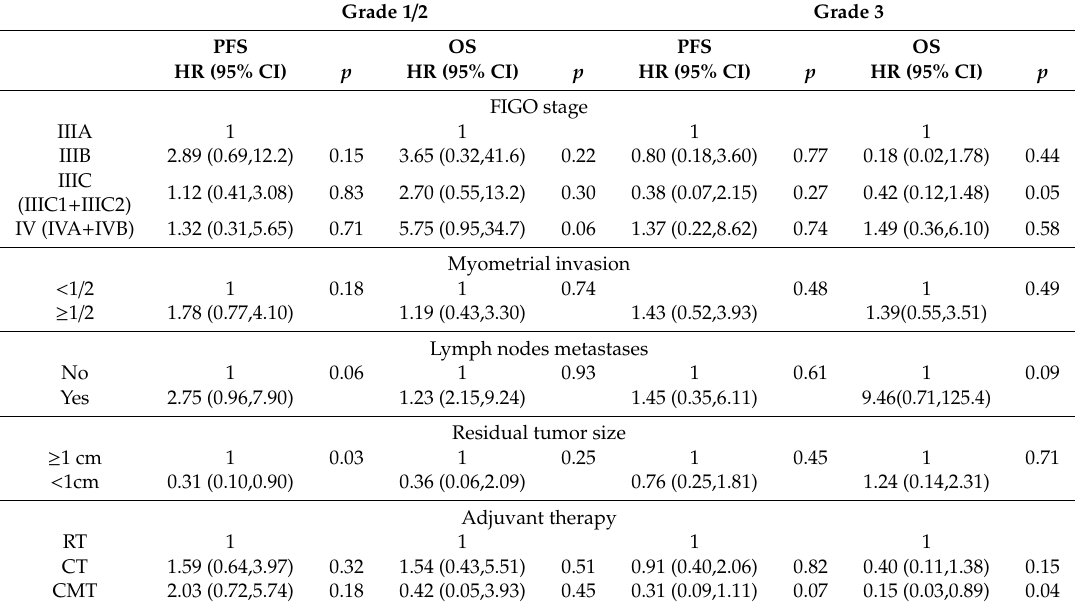
Table 3. Multivariate survival analysis for grade 1 / 2 and grade 3 tumors in advanced-stage